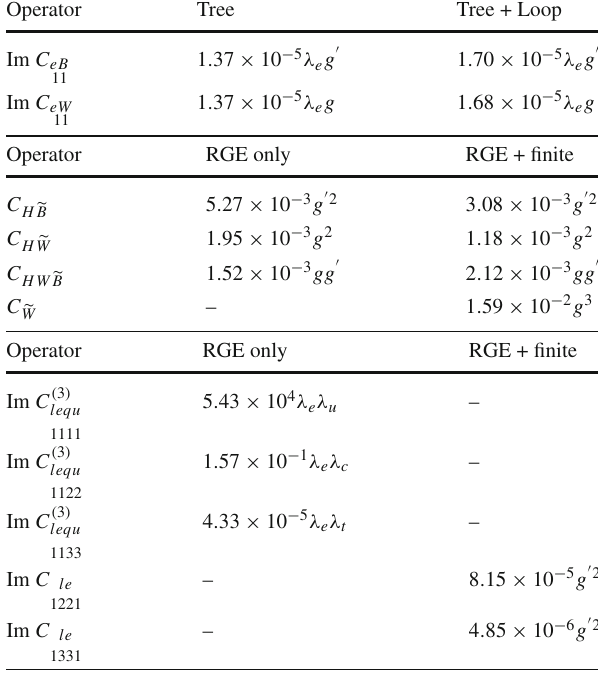
Table 4 Upper bounds on the Wilson coefficients contributing to the EDM of the electron assuming (cid:2) = 5 TeV and no further assumptions. In the upper left table the Wilson coefficients which can enter at tree levelarepresented.Thecolumn‘Tree+Loop’presentsboundsincluding the tree level contribution, the RG running and all finite terms. In the othertablesonecanfindallotherWilsoncoefficientswhichcannotenter at tree level. The left column shows only RG running, while the right column shows both RG running and finite terms. Above, the parameter λ i is the i th diagonal entry of the lepton Yukawa